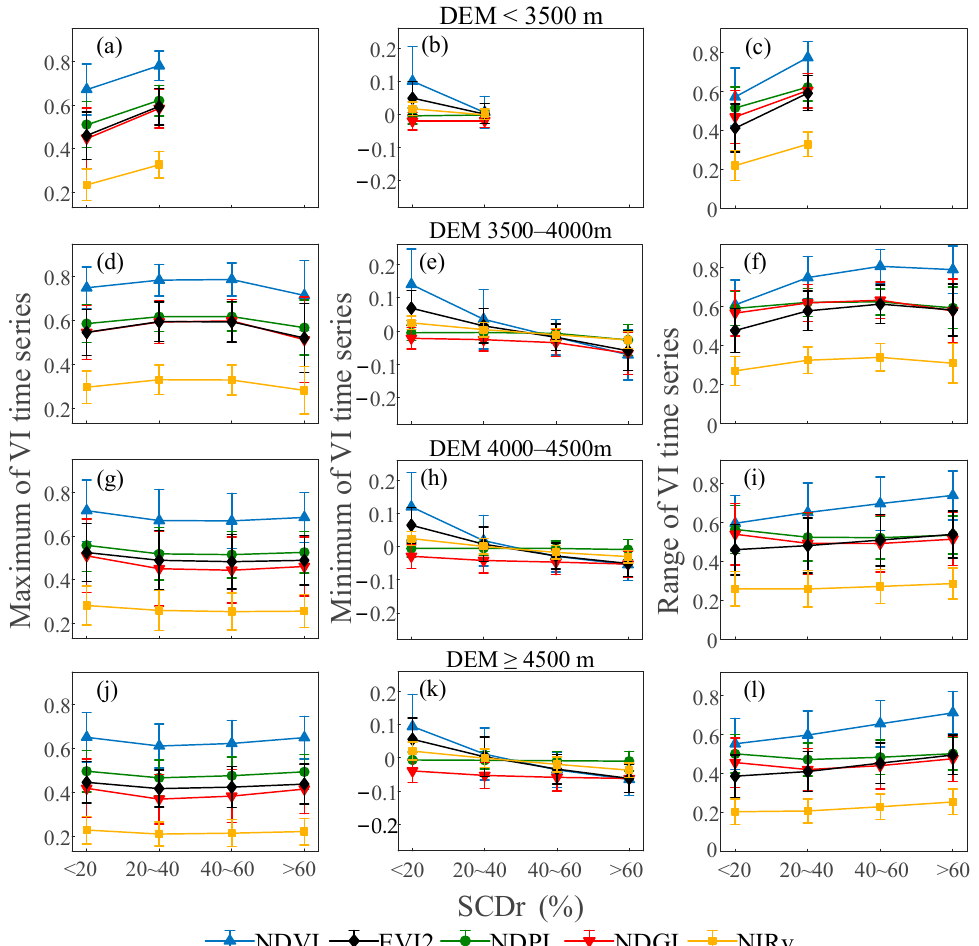
Figure 14. Statistical distribution of the maximum, minimum, and range of the time series of five VIs for different SCDr intervals and elevation zones. ( a – c ), ( d – f ), ( g – i ), and ( j – l ) are statistics for elevation zones of DEM < 3500 m, 3500–4000 m, 4000–4500 m, and ≥ 4500 m, in each of which the maximum, minimum, and range of the VI values over time were plotted.